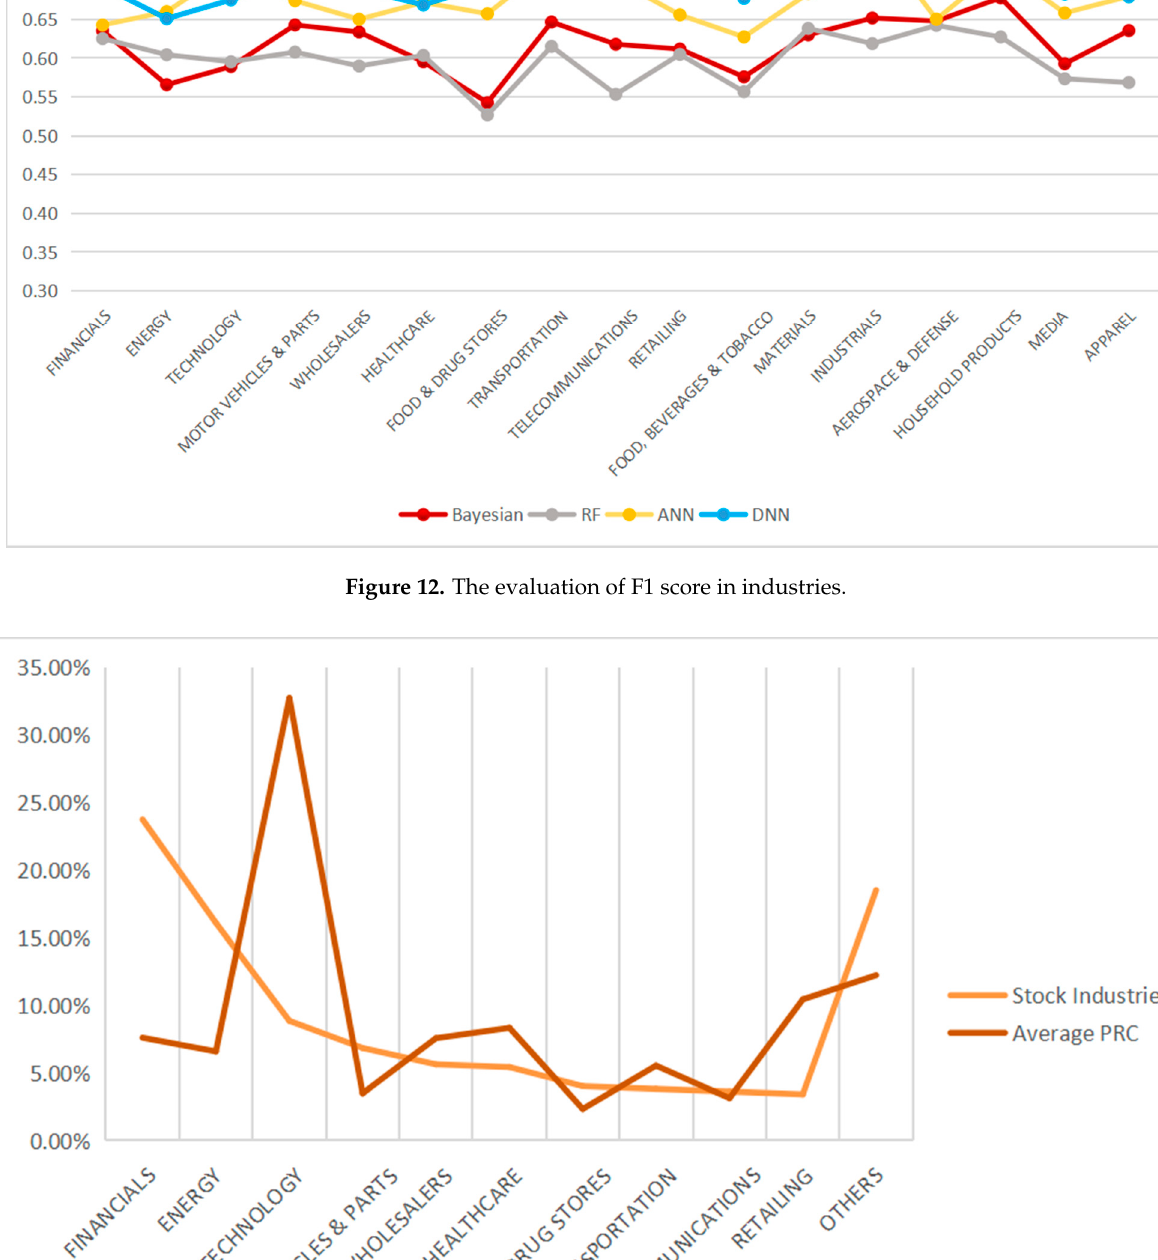
Figure 13. Overview of average PRC and stock industries (2009 to 2017).